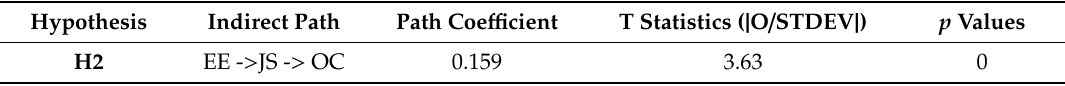
Table 4. Mediation analysis (indirect